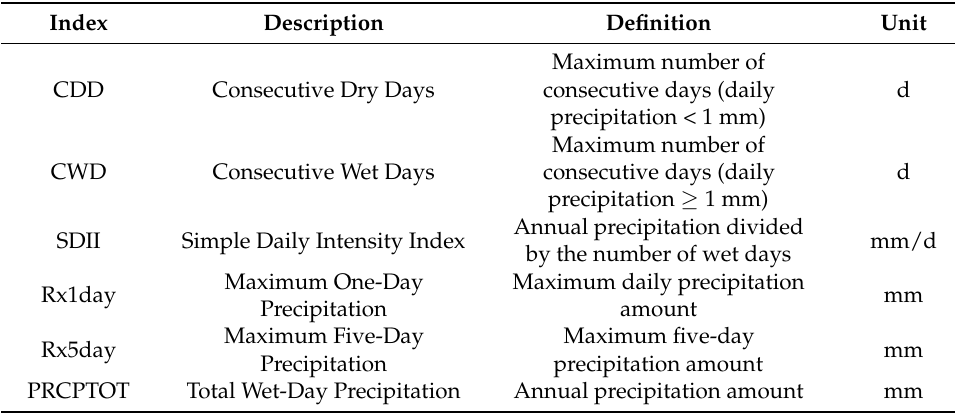
Table 1. Definitions of extreme precipitation